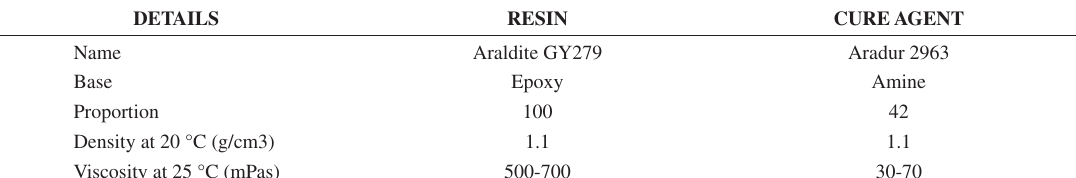
Table 1. The characteristics and proportions of the Polymeric system.